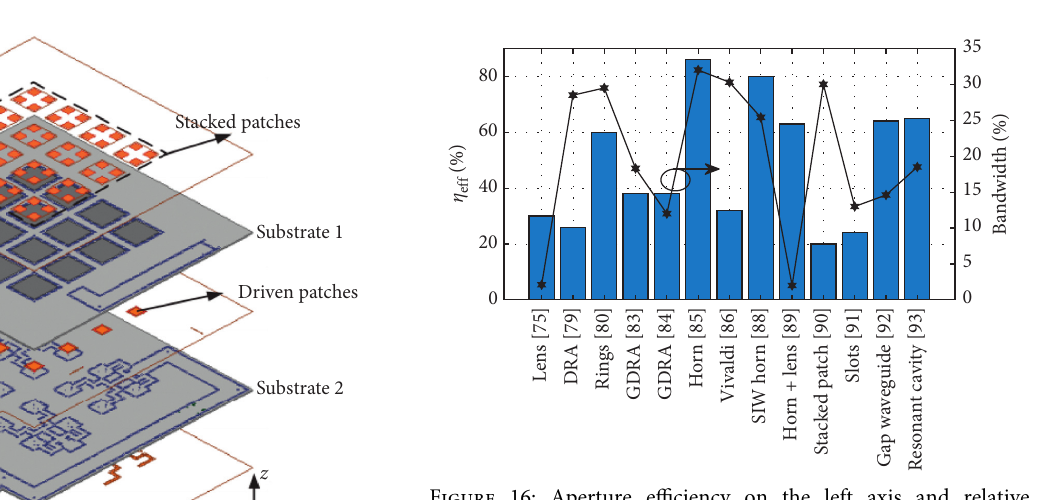
Figure 14: HSIW Horn antenna element (a) and antenna array (b) proposed in [88] ©2019 IEEE.